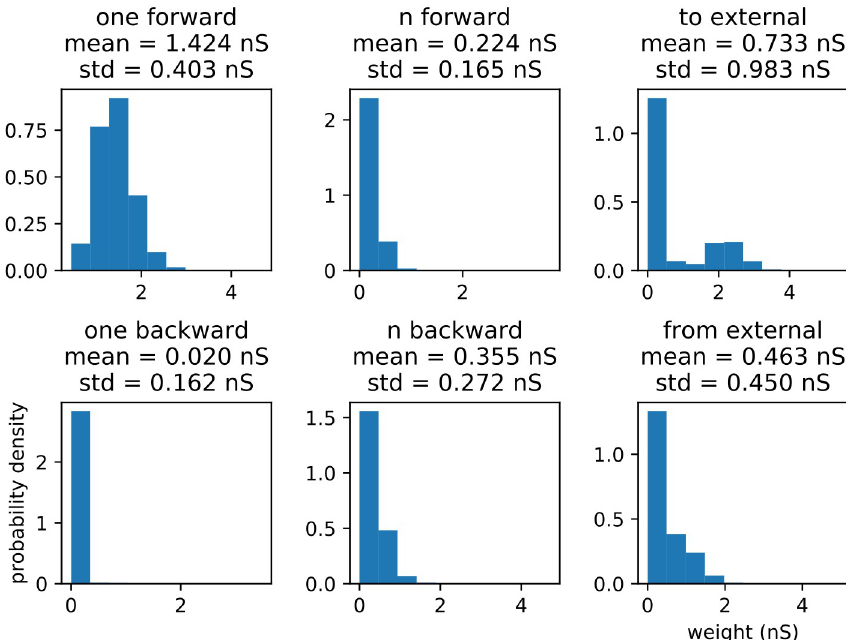
Fig 8. Connection strength histograms for important categories of connections. Strength histograms of the important categories of connections, along with means and standard deviations for each distribution. (A) “one forward,” or connections from one input cluster to the subsequent input cluster. (B) “n forward,” or connections from an input cluster to other input clusters occuring more than one step after them in the trained sequence. (C) “to external,” or connections going from input clusters to untrained (or at least indirectly trained) portions of the netork. (D) “one backward,” or connections from one input cluster to the immediately previous one in the trained sequence (the low count is due to rounding, thresholding, and sparse matrix storage artifacts). (E) “n-backward,” or connections from an input cluster to earlier (but not immediately previous) input clusters in the trained sequence. (F) “from external,” or connections from the untrained (or indirectly trained) portion of the network to the input clusters.